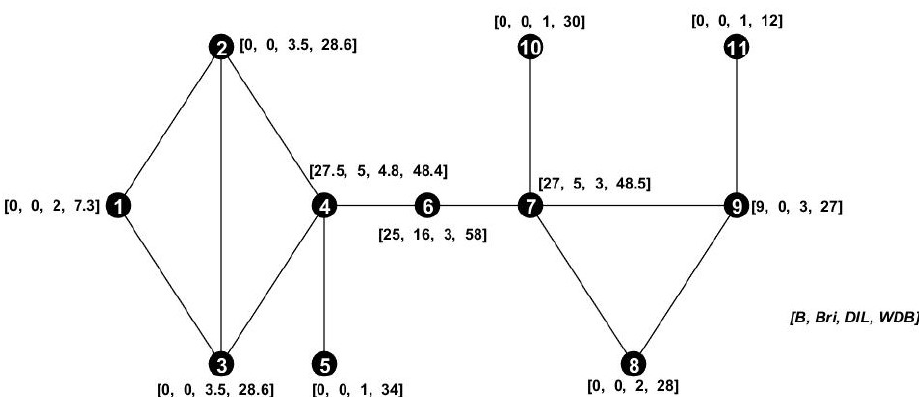
Figure 3. The synthetic network used to compare the network measures, betweenness centrality, bridgeness, and DIL, with the proposed measure, WDB. Numbers 1 to 11 are node counts, and values in brackets represent the network measure values in the following order: [ B , Bri, DIL, and WDB]. Node 6 is a global bridge node that connects two subnetworks. Nodes 4 and 7 are hubs that are connected to most of the nodes in the subnetworks. Nodes 5, 10, and 11 are the dead-end